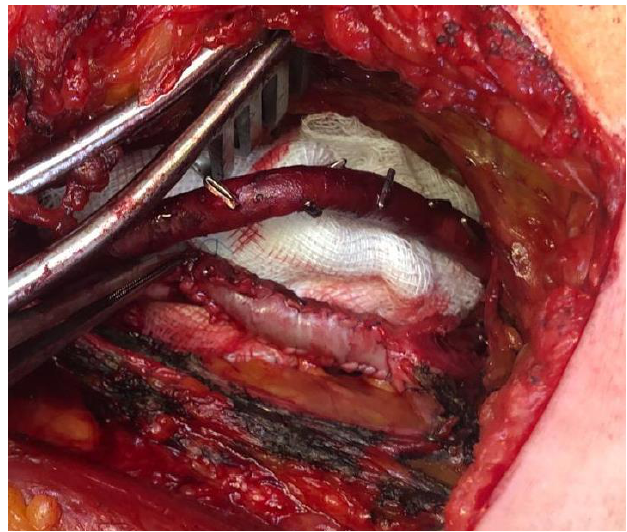
Figure 4. Tangential aneurysmectomy of the PVA and patch angioplasty with bovine pericardium.